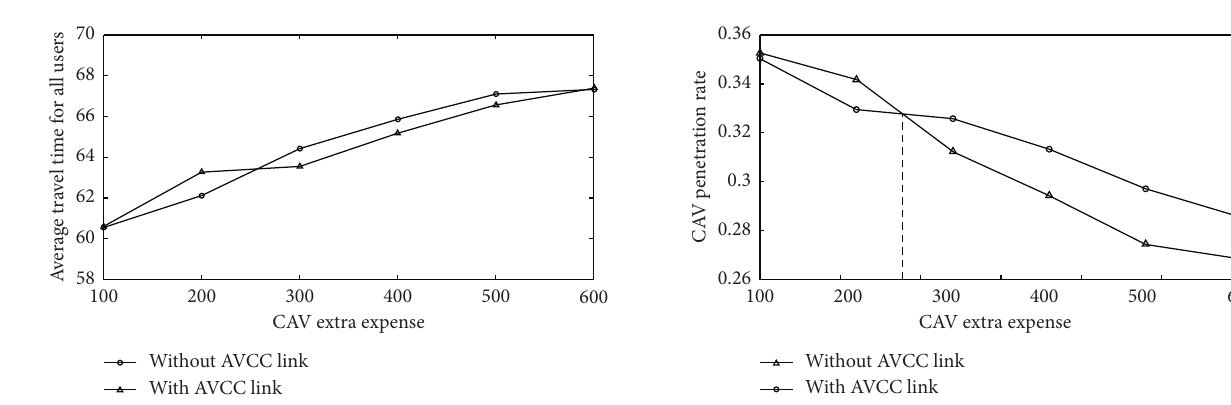
Figure 9: Average travel time for all network users. Figure 10: CAV penetration rate under various extra